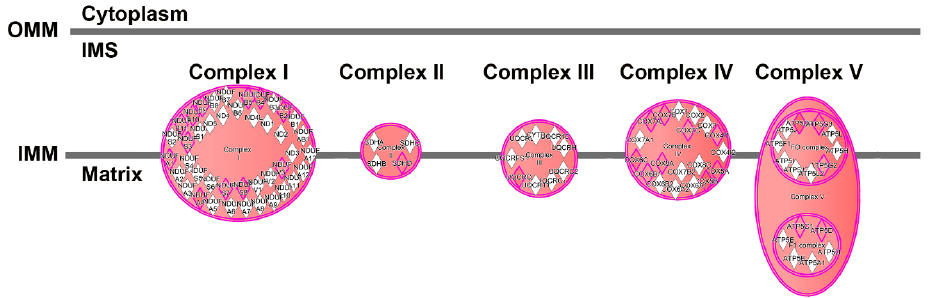
Figure 12. Enrichment of genes involved in the electron transport chain in cluster 5, based on the DEGs between cluster 5 and clusters 1–4. Pink border indicates molecules with expression data, double border indicates a group or complex of molecules. Orange fill indicates increased expression of the molecules and of the double border complexes. Figure adapted from an IPA-generated diagram.